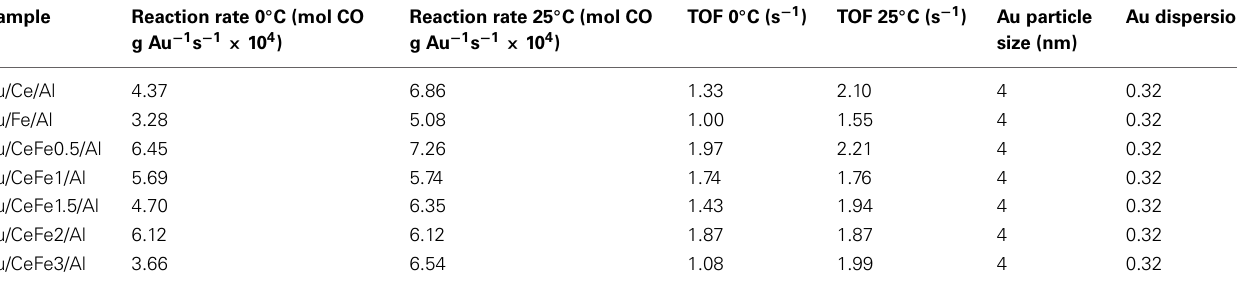
Table 3 | Low temperature CO oxidation reaction rates and TOF values for the gold catalysts at 0 ◦ C and 25 ◦ C.